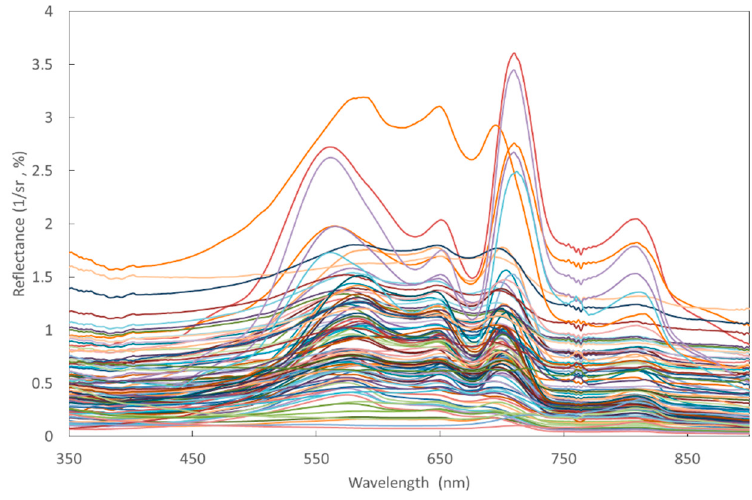
Figure 3. Reflectance spectra of all studied Estonian and Swedish lakes. Table 1. Minimum, maximum, and mean concentrations of optically active substances measured in lakes under investigation. Concentration of Chl is in mg·m − 3 , TSS, SPIM, and SPOM in mg·L − 1 and a CDOM (400) in m − 1 . Only maximum values are provided if there is a single measurement from a particular lake.